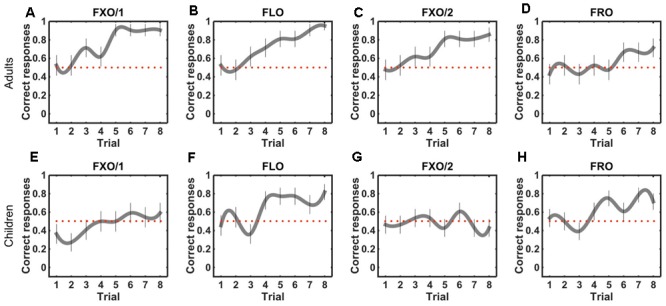
String recognition performance (correct responses over trials) in adults exposed to a fixed order grammar (FXO/1) or a flexible order grammar (FLO) in Experiment 1 (A,B) and to a fixed order grammar (FXO/2) or a free order grammar (FRO) in Experiment 2 (C,D), and in children exposed to the same grammars in Experiments 3 (E,F) and 4 (G,H). Different charts correspond to different groups of adults and children, trained on different grammars. Error bars denote standard errors of the mean. Red dotted lines show chance level (0.5).